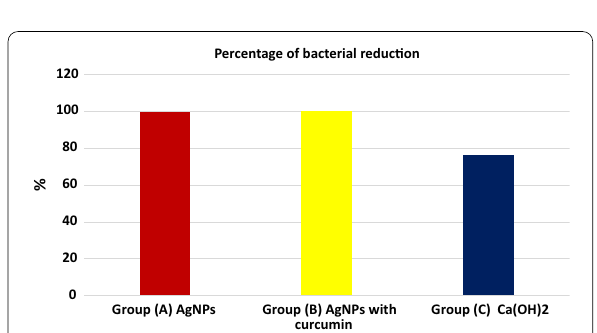
Fig. 9 Bar chart representing bacterial reduction in tested